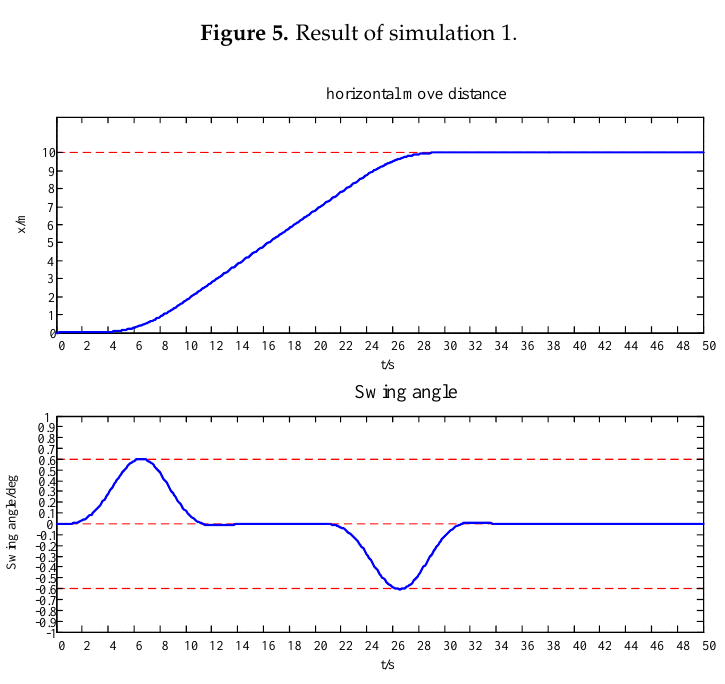
Figure 5. Result of simulation 1.